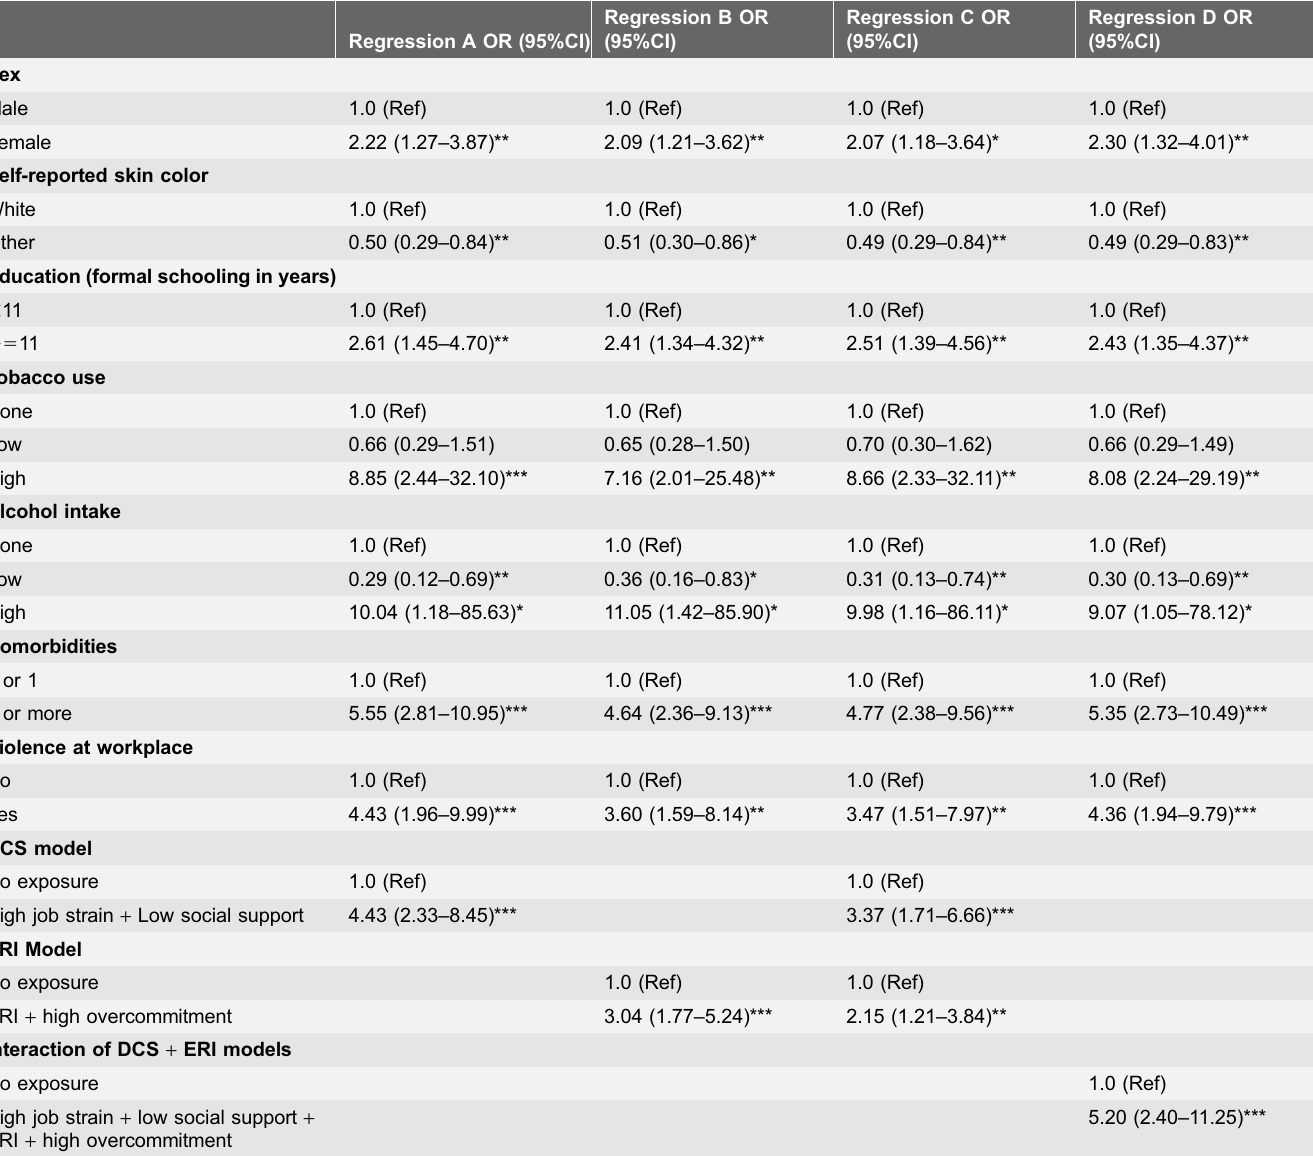
Table 3. Multiple logistic regression analyses and factors associated with long-term sickness absence due to mental disorders a , Sa˜o Paulo, Brazil, 2011 (N 5